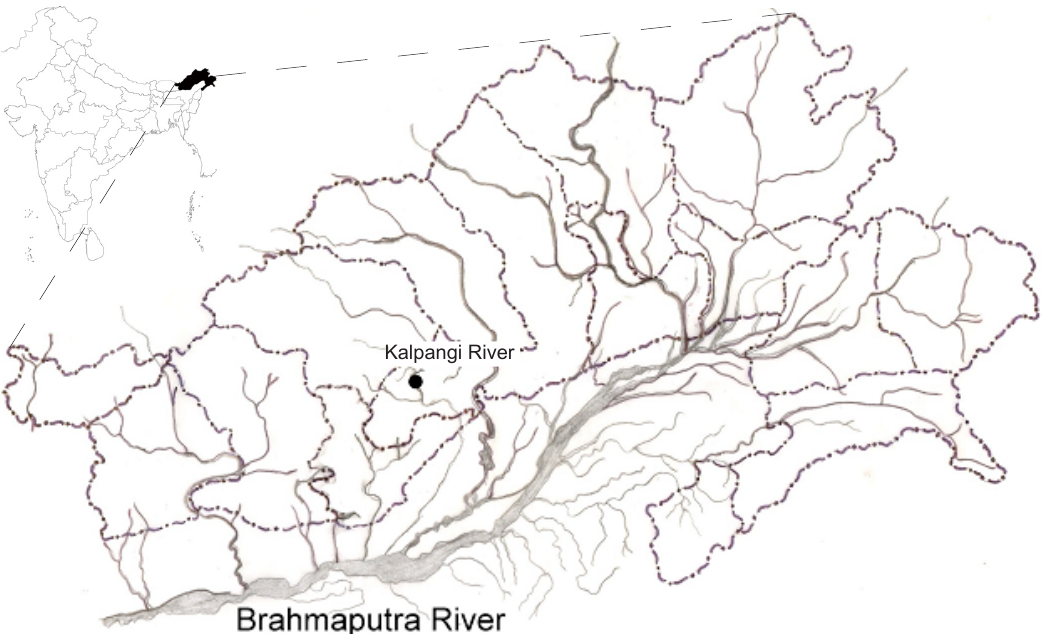
Figure 1. Collection site (marked as black spot) of Garra kalpangi sp. nov. in Kalpangi River, Lower Subansiri District, Arunachal Pradesh, India